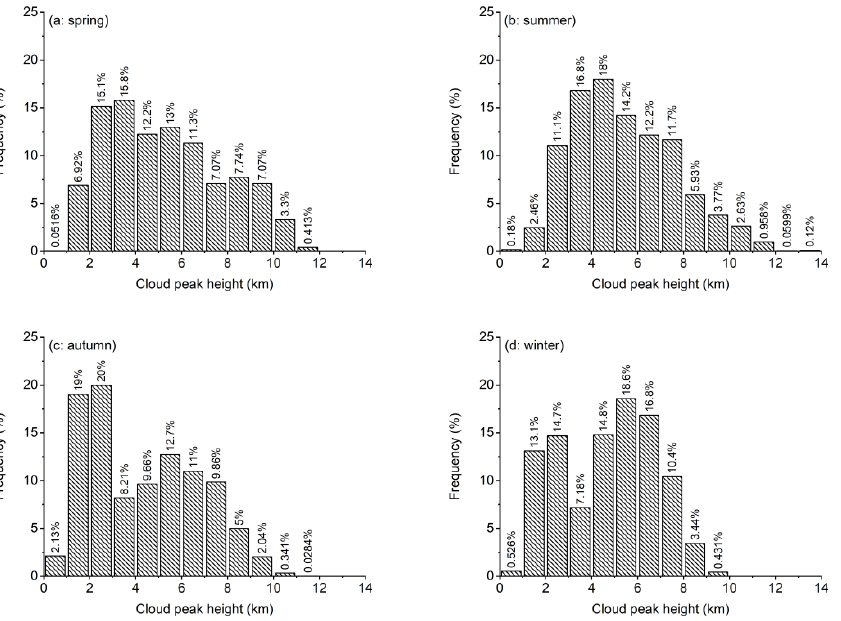
Figure 7. Frequency distributions of the cloud peak height in ( a ) spring, ( b ) summer, ( c ) autumn and ( d ) winter.